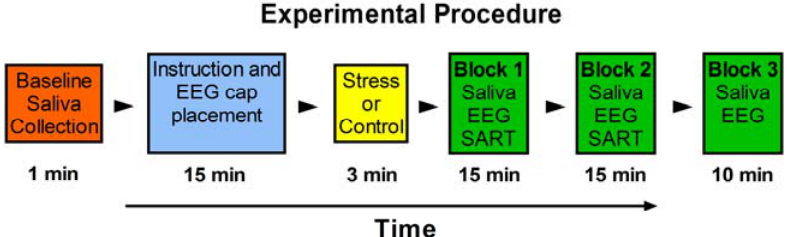
Figure 1. The testing procedure. The testing procedure consisted of 3 testing Blocks after stress (SECPT) or control stress